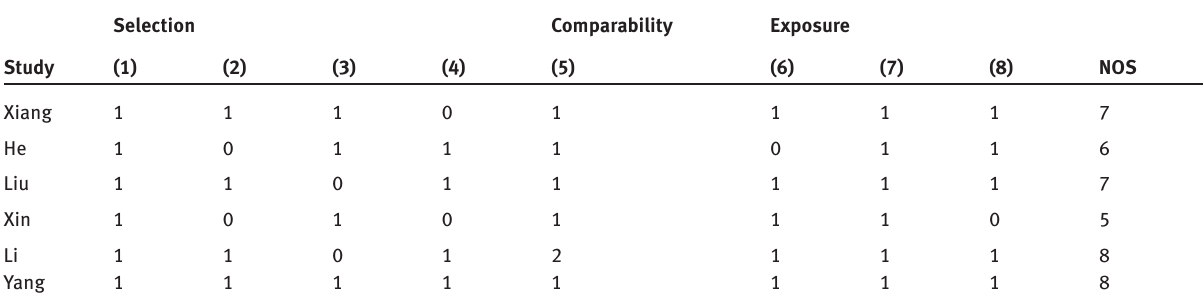
Table 2: The quality assessment for the 6 studies Selection Study